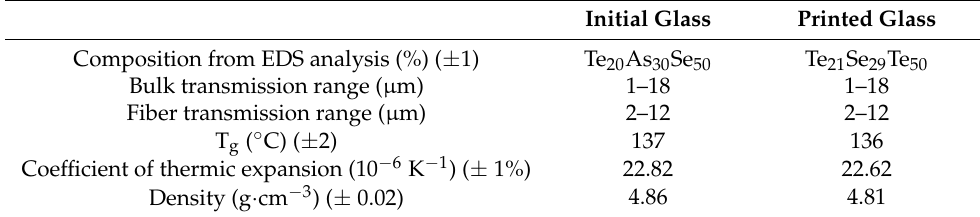
Table 1. Physical property comparison of a melt/quenched glass used as the initial glass and a printed